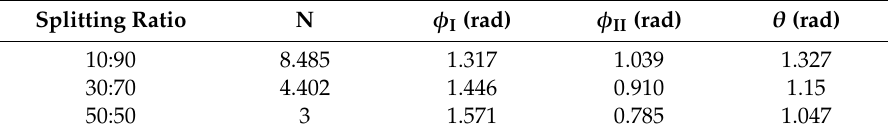
Figure 3. Relative curves of ( a ) splitting ratio and N ( b ) ratios with phases of φ I , φ II and θ . Table 1. Splitting ratio parameters with N , φ I , φ II , and θ.